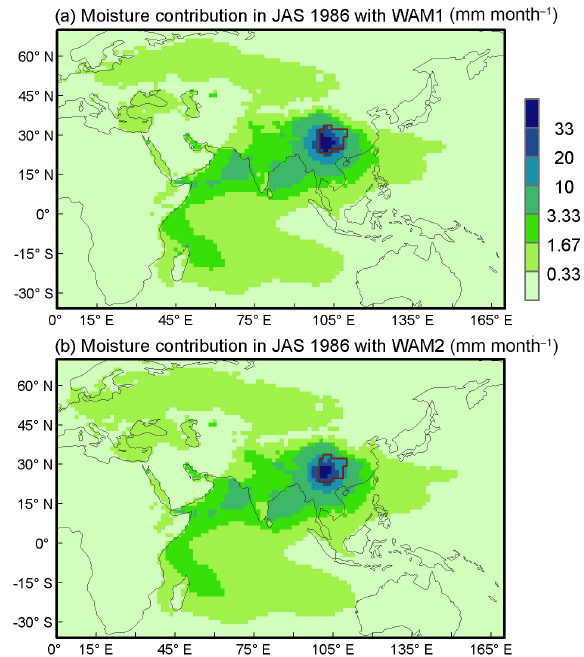
Figure 9. Moisture contribution of the SWC precipitation in JAS 1986 with WAM1 (a) and WAM2 (b)